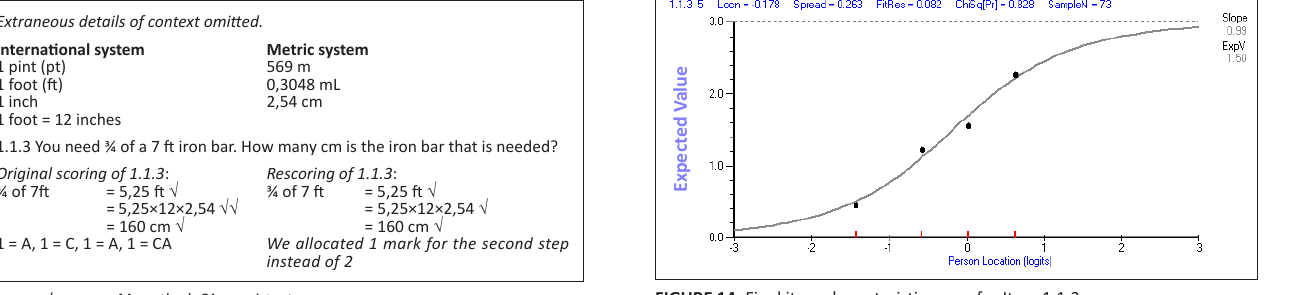
FIGURE 14: Final item characteristic curve for Item